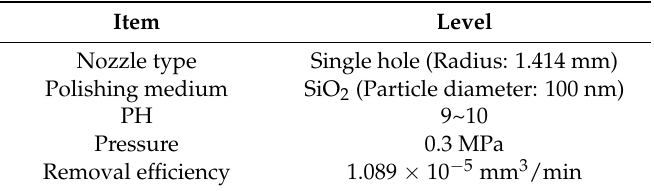
Table 3. Parameters of elastic jet polishing